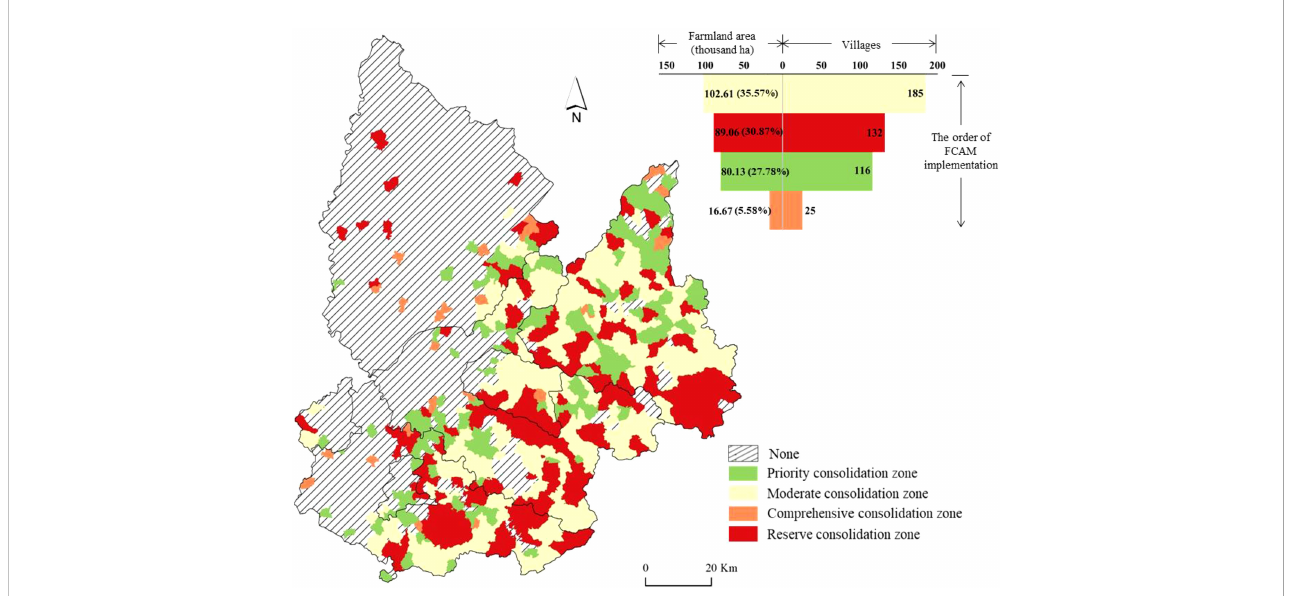
FIGURE 6 Zoning of FCAM schemes. FCAM, farmland consolidation suitable for agricultural